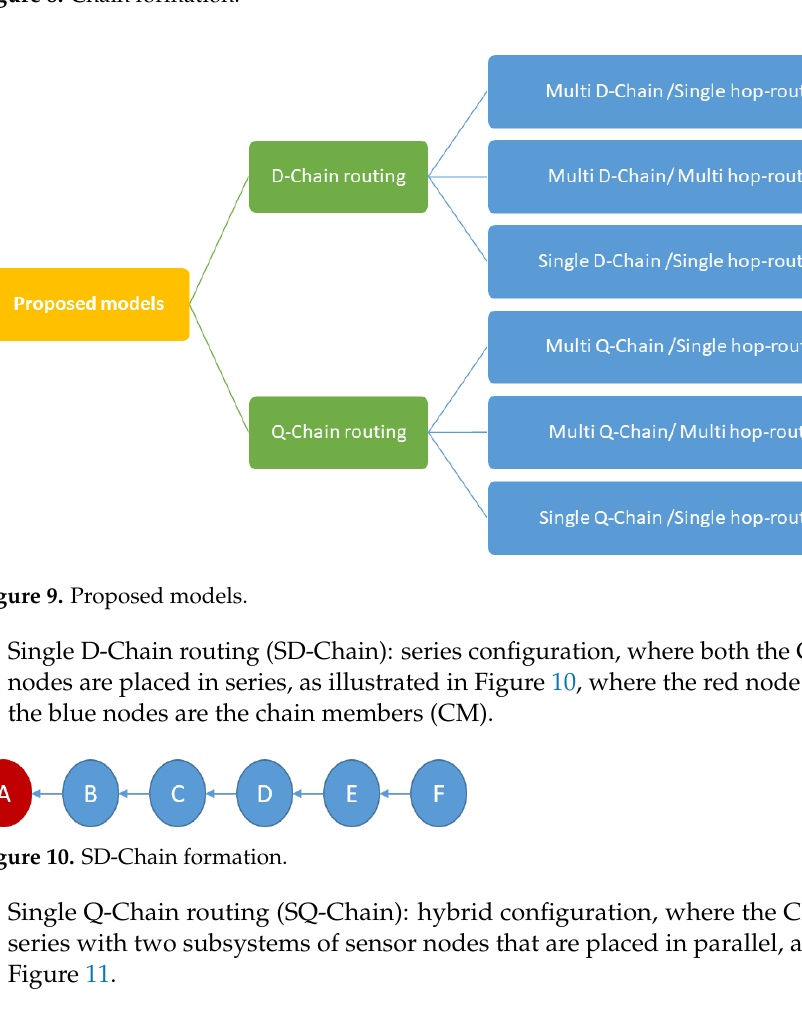
Figure 10. SD-Chain formation.